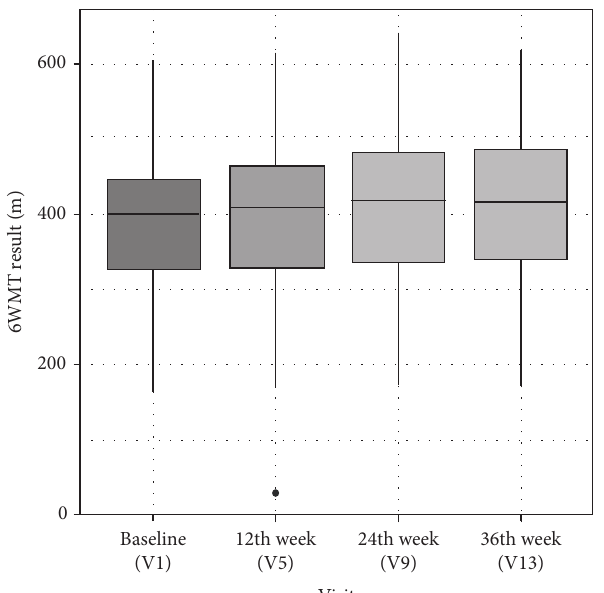
Figure 2: Results of 6-minute walk test (6MWT) at visit 1, visit 5 (after 12weeks), visit 9 (after 24 weeks), and visit 13 (after 36 weeks).